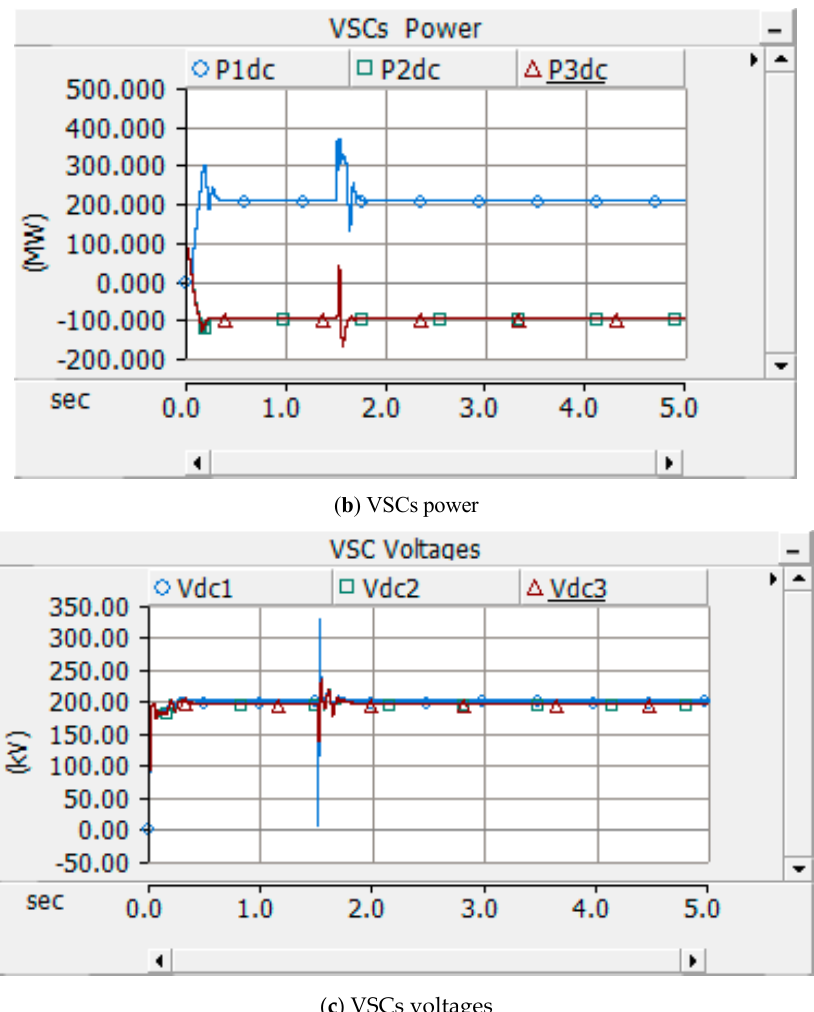
Figure 12. Three-phase to ground fault at sending end of transmission line for 0.03 s duration.